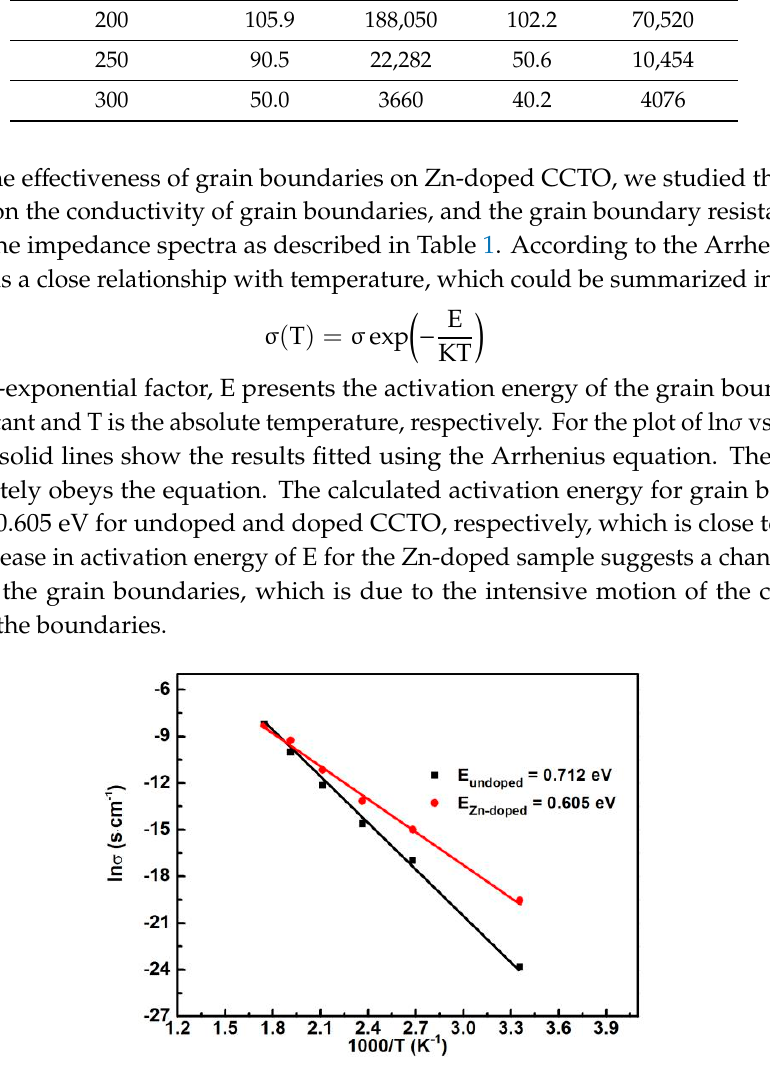
Figure 6. ln 𝜎 vs. temperature for undoped and Zn doping CCTO in the form of Arrhenius